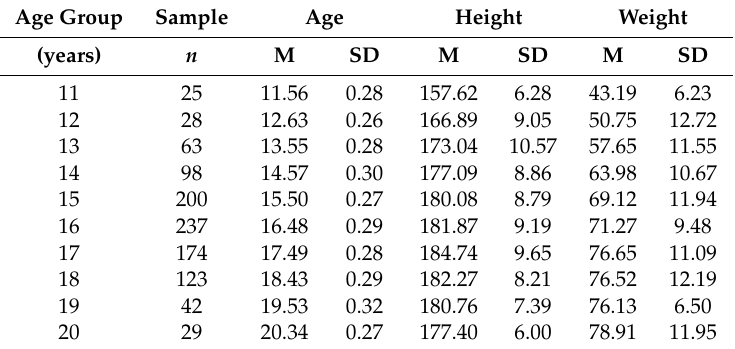
Table 1. Sample sizes and descriptive statistics (means (M) and standard deviations (SD)) for age, height, and weight of male athletes by age group.